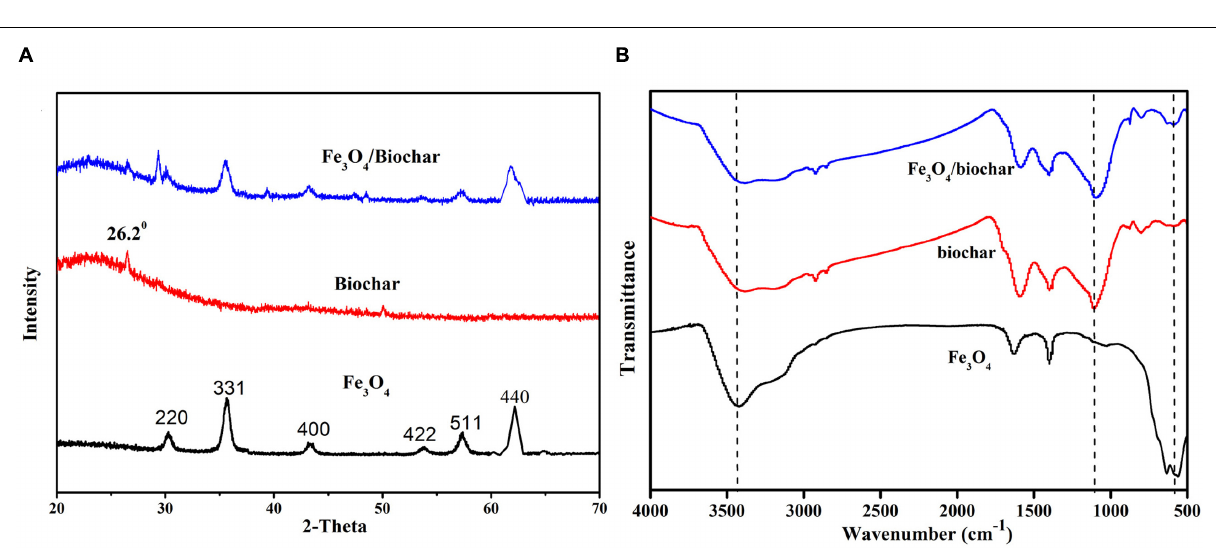
FIGURE 2 | (A) X-ray diffraction (XRD) patterns and (B) FTIR spectra of Fe 3 O 4 , biochar, and Fe 3 O 4